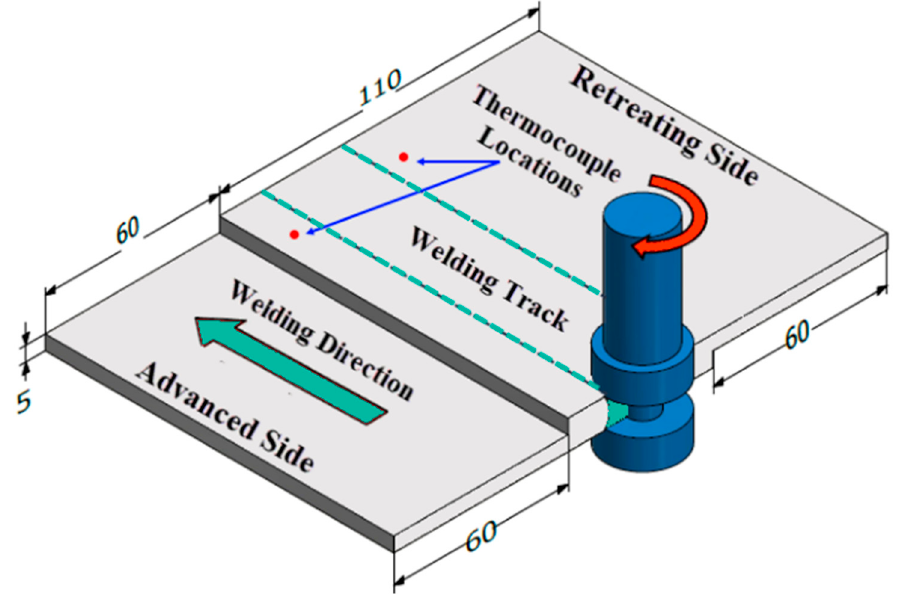
Figure 1. Dimensions of BT-FSW lap joint (all dimensions in mm).